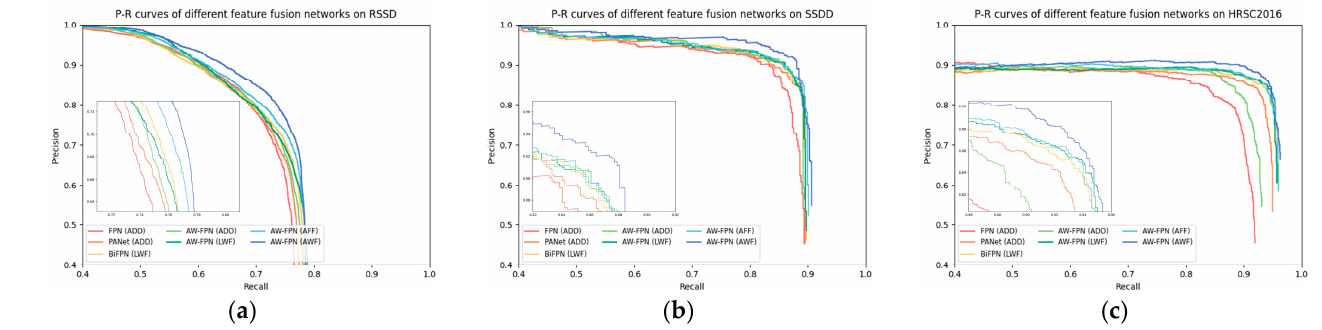
Figure 22. P–R curves of RetinaNet-R with different feature fusion networks on ( a ) RSSD, ( b ) SSDD, and ( c ) HRSC2016.